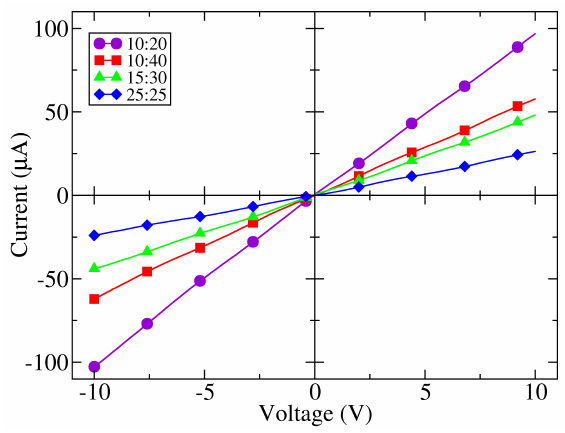
Figure 3. Dark current-voltage characteristics of all photodetectors at room temperature showing linear